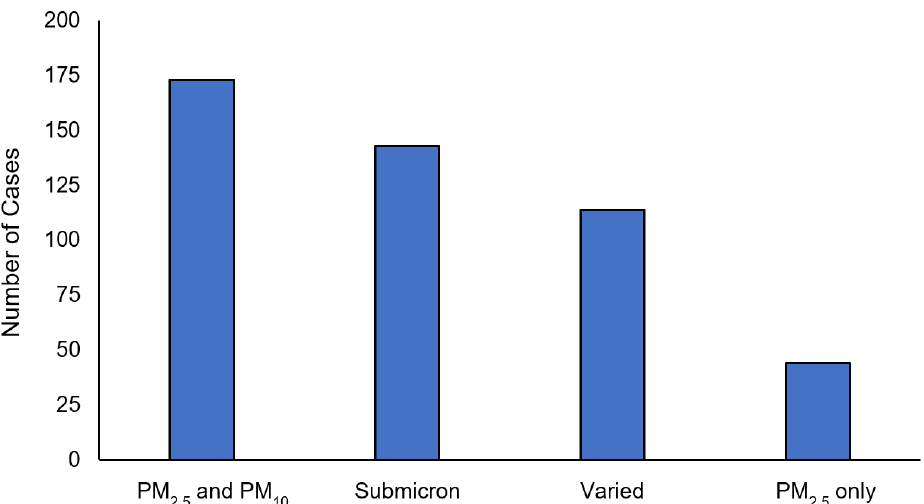
Figure 5. Total number of cases retrieved in our systematic review of the literature on in situ aerosol – PBAP research in Brazil distributed by size (µm) of particles investigated. Legend: PM 2.5 and PM 10 refers to the cases that investigated both PM 2.5 (fine; <2.5 µ m) and PM 10 (coarse-mode; <10 µ m) aerosols; submicron refers to the cases that examined only particles <1 µ m; varied refers to the cases that studied different sizes of particles (i.e., 0–2000 µ m); and PM 2.5 only refers to the cases that researched fine-mode aerosols only (i.e., <2.5 µ m).